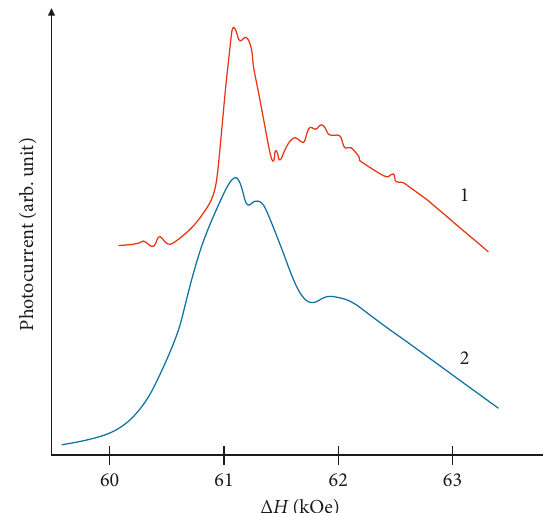
Figure 20: CR line shapes of two samples, 5 (curve 2) and 6 (curve 1), with similar values of the neutral and ionized im- purity concentrations. The electric field takes prebreakdown values;